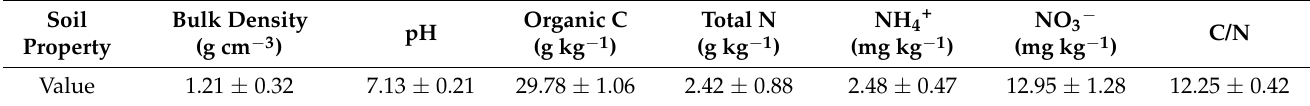
Figure 1. Geographical location ( a ) and the temperature and precipitation ( b ) of the study site. Table 1. Physical-chemical properties in the upper 15 cm of soil before N addition ( n = 3).